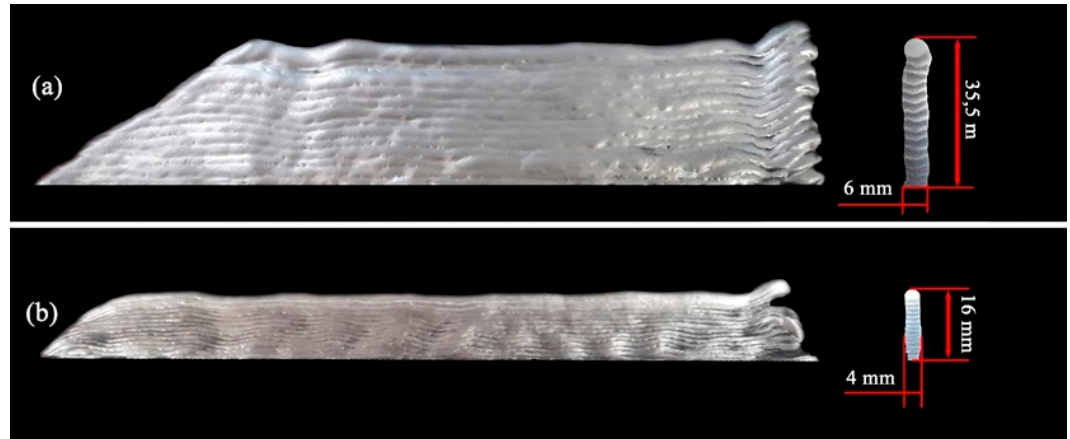
Figure 6. WAAM 15-layer-high walls using the lower and upper values of the deposition speed range (average current of 81 A and a voltage of 12.5 V): ( a ) lower speed limit (42 cm/min); and ( b ) upper speed limit (175 cm/min).